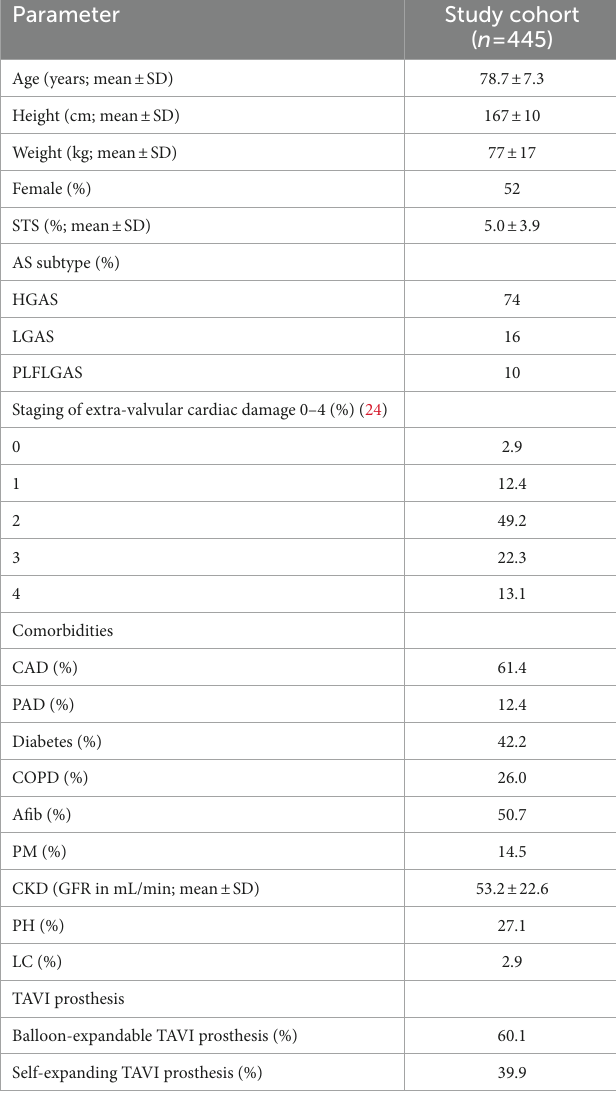
TABLE 1 Baseline characteristics of the study